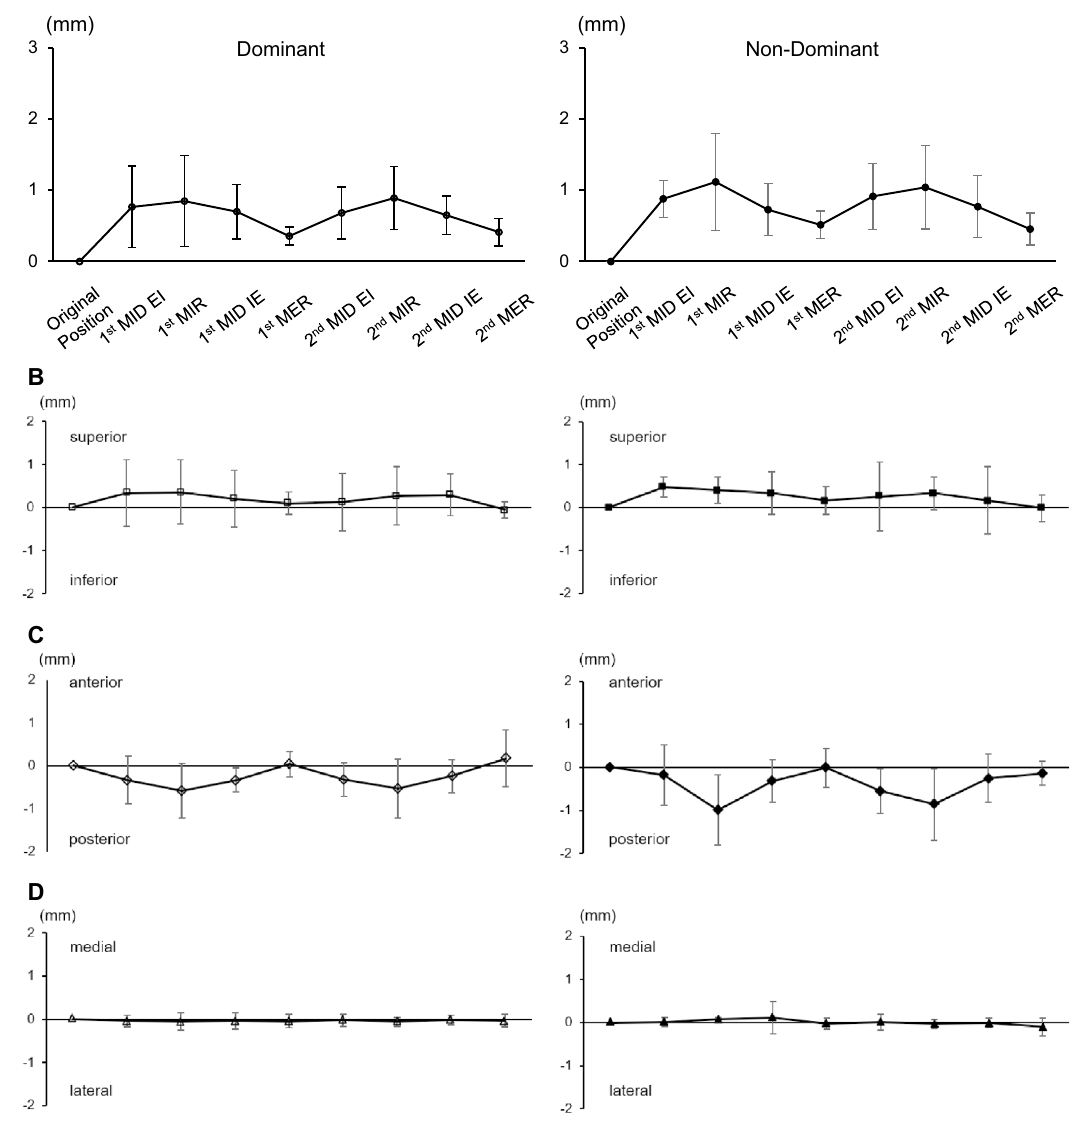
Figure 4. Distance of glenoid contact area centroid from original position to each position. ( A ) Absolute value of dominant shoulder and non-dominant shoulder. ( B ) Superior/inferior directions, ( C ) anterior/posterior directions, ( D ) medial/lateral directions. MER; Maximum external rotation. MIR; Maximum internal rotation. MID EI; Midpoint from MER to MIR, MID IE; Midpoint from MIR to